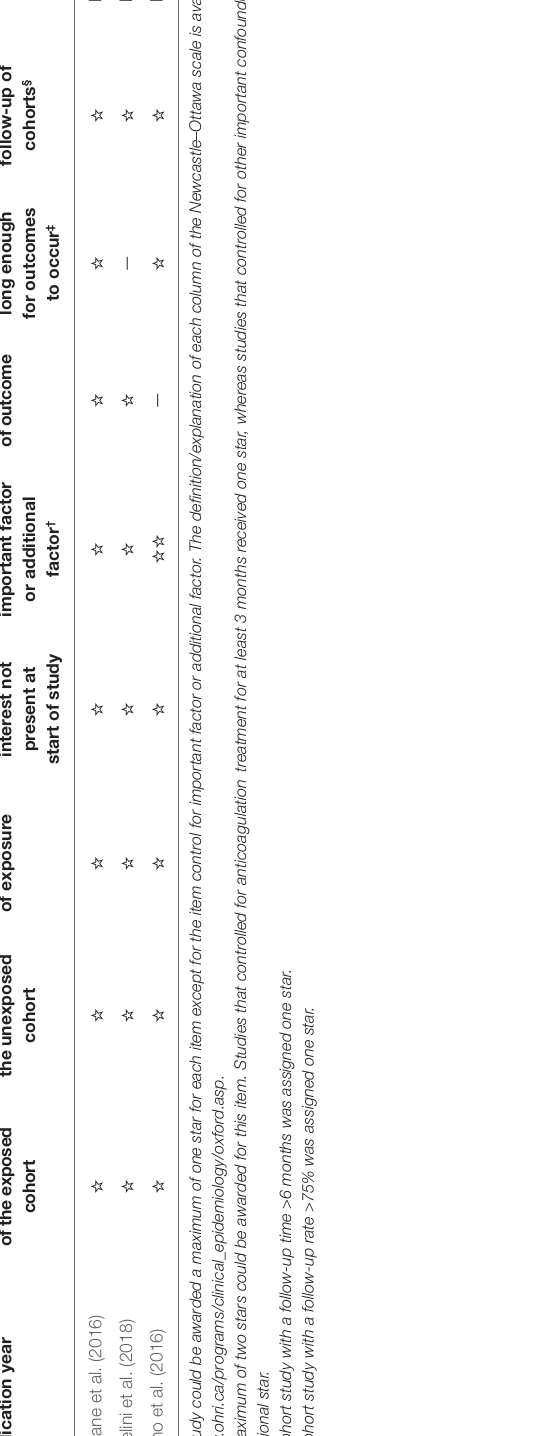
interval (CI): 0.49–0.75; I 2 : 0%; p < 0.00001] ( Figure 2 ). Inspection of the funnel plot did not reveal publication bias ( Supplementary Figure 1 ). A subgroup analysis on studies comparing factor Xa inhibitors (apixaban, edoxaban, and rivaroxaban) with traditional anticoagulants was performed, demonstrating a lower recurrence for the factor Xa Inhibitors group (RR: 0.60; 95%CI: 0.48–0.74; I 2 : 5%; p < 0.00001) ( Figure 3 ), rivaroxaban group (RR: 0.62; 95%CI: 0.42–0.92; I 2 : 15%; p = 0.02) ( Figure 4 ), and edoxaban group (RR: 0.63; 95%CI: 0.47–0.83; I 2 : 0%; p = 0.0009) ( Figure 5 ). Subgroup analysis on RCTs showed a lower recurrence for the DOACs group ( Supplementary Figure 2 ) while that of the prospective cohort studies did not demonstrate a statistical significance ( Supplementary Figure 3 ).